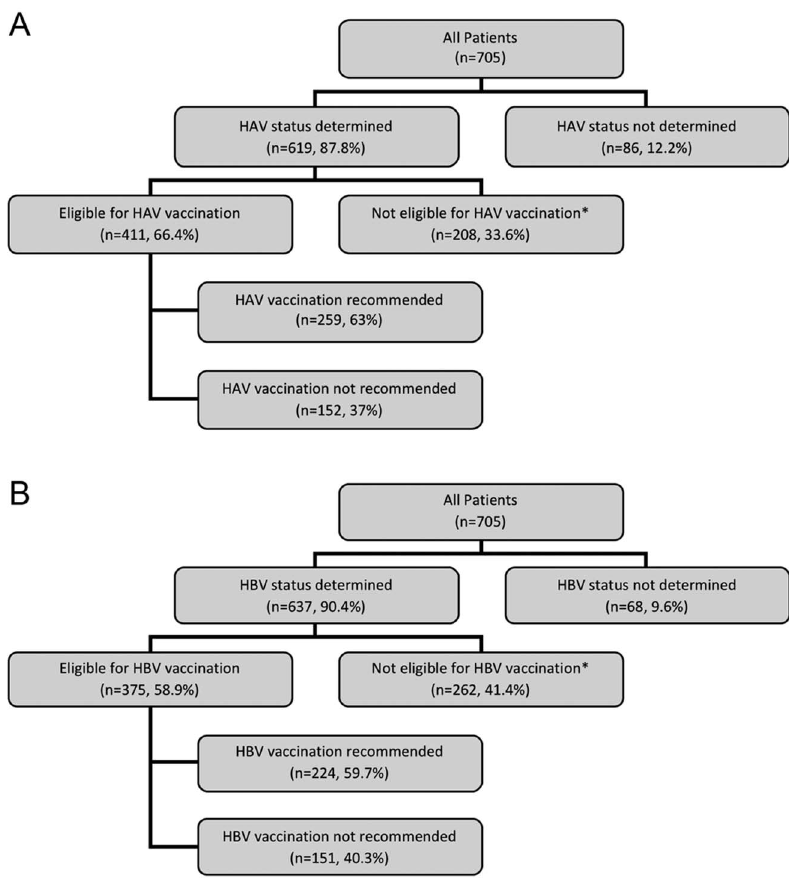
Figure 1. Flowcharts showing how often new patients with chronic liver disease were tested for, eligible for, and were recommended hepatitis vaccination in the liver clinic. A) Hepatitis A vaccination. *Patients not eligible for HAV vaccination included those with positive HAV antibody or who reported completion of the HAV vaccination series. B) HBV vaccination. *Patients not eligible for HBV vaccination included those who had a positive HBs antibody and/or positive HBc antibody or who reported completion of the HBV vaccination series.